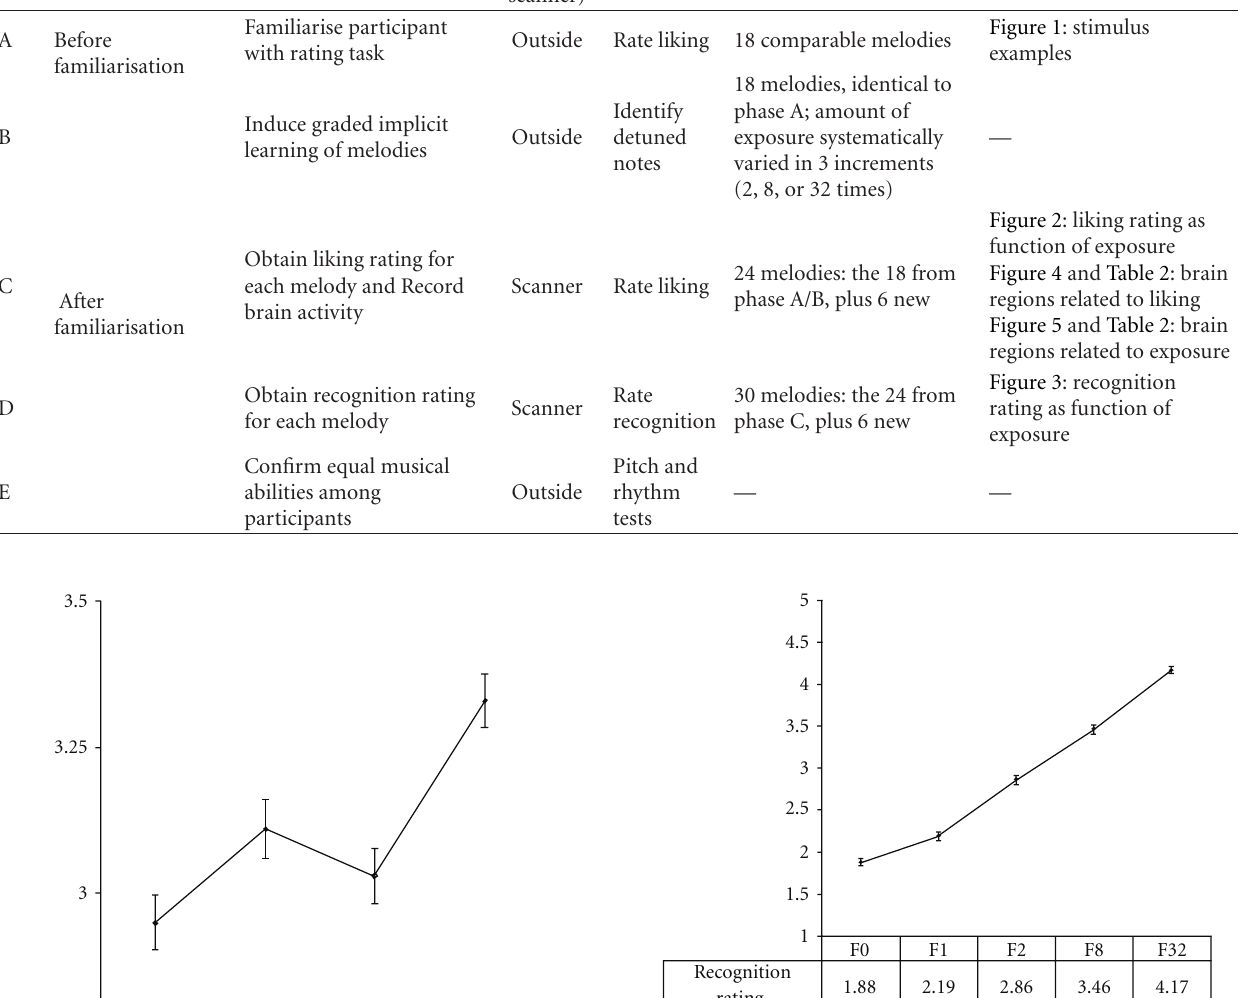
Figure 1: stimulus